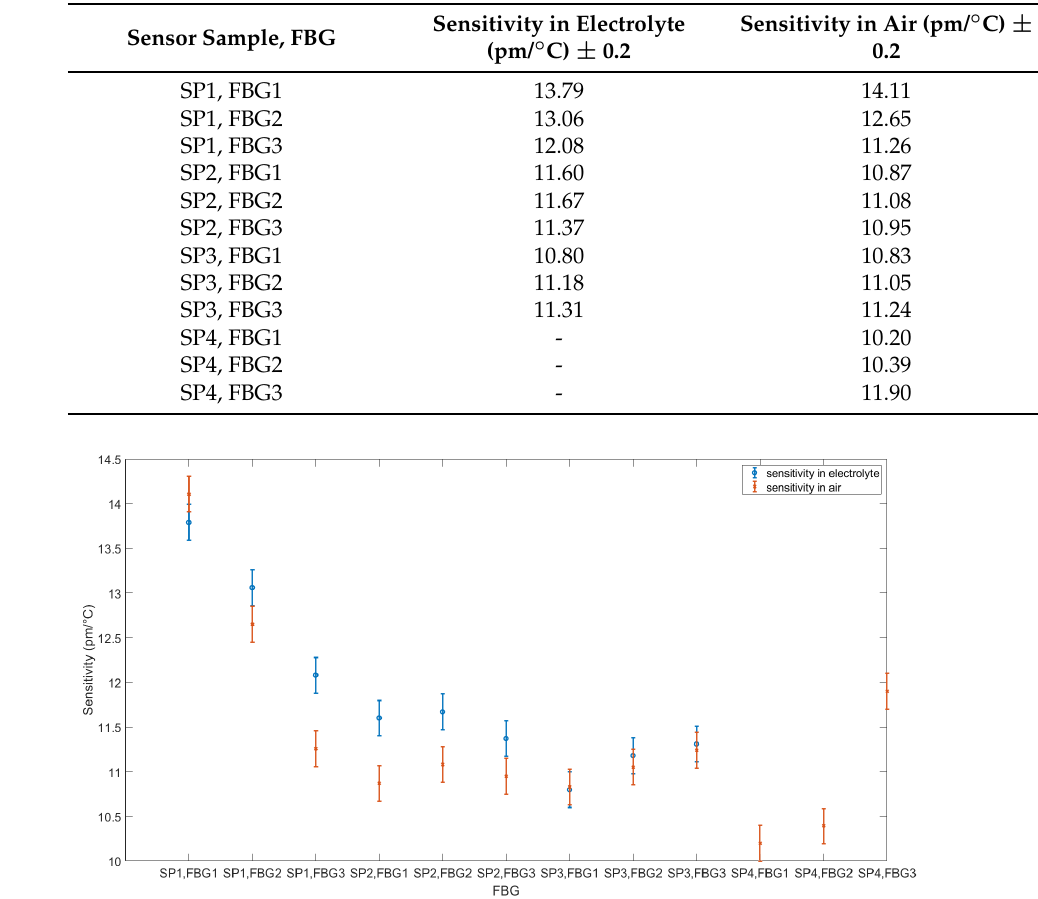
Table 2. The sensitivities for each FBG in the electrolyte and air. SP1: optical fiber in PEEK capillary, single-point mounting; SP2: optical fiber in fused silica tube with polyimide coating, single-point mounting; SP3: optical fiber in fused silica tube, removed polyimide coating, single-point mounting; SP4: optical fiber in fused silica tube, removed polyimide coating, double-point mounting. Sensor Sample, FBG